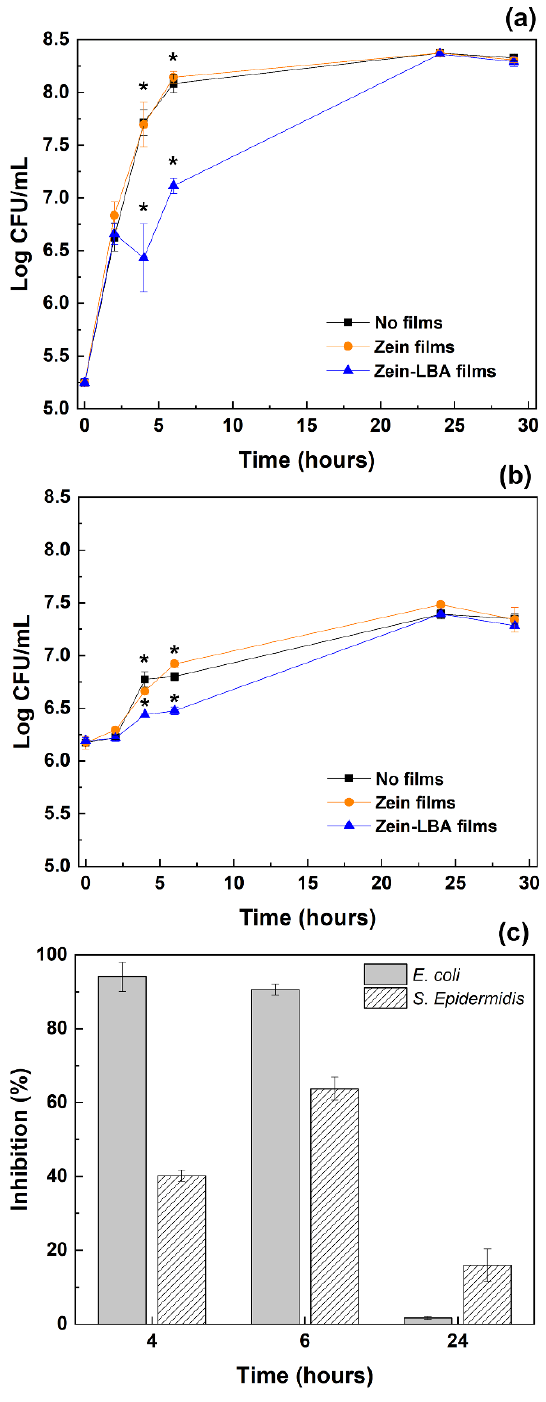
Figure 8. Effect of zein and zein-LBA films on the growth of ( a ) E. coli and ( b ) S. epidermidis at different time points. The dLB medium was used as control (“no films”). Data are expressed as means ± standard deviations of log 10 CFU/mL during microbial growth in dLB without films and with zein and zein-LBA films. Values with “*” are significantly different at p < 0.05. ( c ) Inhibition percentages for zein-LBA films for the two bacterial strains at different time points (4, 6, and 24 h).